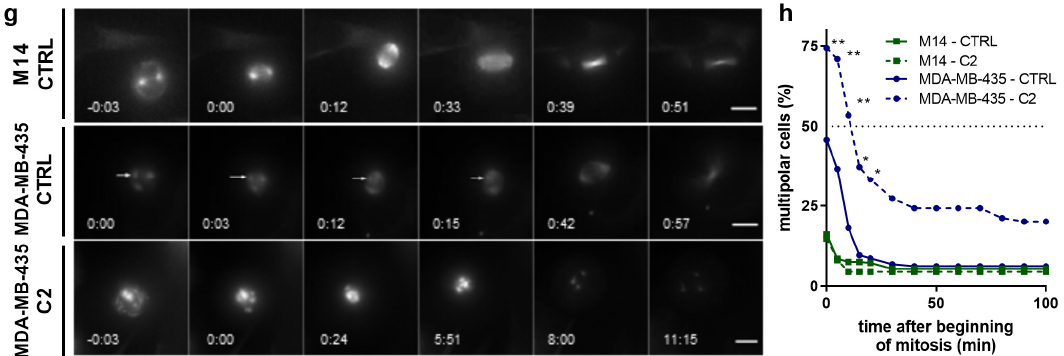
Figure 5. Effects of C2 treatment on melanoma cells with normal or elevated number of centrosomes. ( a ) Representative images of M14 and MDA-MB-435 cells stained for centrin (green), γ -tubulin (red), and DAPI (blue). Scale bar = 5 µm. ( b ) Image-based quantification of the number of centrioles per cells. Results from N = 4 experiments with n = 165 cells for M14 and 164 cells for MDA-MB-435 cells. (c) Efficacy of C2 and corresponding single drug treatments in M14 and MDA-MB-435 cells, ** p < 0.01 versus all corresponding single drug treatments in a one-way ANOVA with posthoc Tukey’s multiple comparison test. ( d ) Outcomes of M14 and MDA-MB-435 cells treated with CTRL (0.1% DMSO) or C2 during 24h movies. ** p < 0.0001 vs. CTRL in a Fisher’s exact test, N = 3 experiments, n = 610–515 cells for M14, and n=355-297 cells for MDA-MB-435 cells. ( e ) Mitotic timing from NEBD until formation of a cleavage furrow in min. ** p < 0.0001 for M14 cells and * p = 0.0002 for MDA-MB-435 cells, (CTRL vs. C2 ) in a Mann–Whitney Test from N = 3 experiments with n = 227–122 cells for M14 and n = 140–60 cells for MDA-MB-435. ( f ) Mitotic outcome of M14 and MDA-MB-435 cells. ** p < 0.0001 and * p < 0.001 vs. CTRL in a Fisher’s exact test, N = 3 experiments with n = 227–122 cells for M14 and n = 140–60 cells for MDA-MB-435. ( g ) Time-lapse images of M14 and MDA-MB-435 cells undergoing mitosis, stained with SiR-Tubulin. Mitotic timing in h:mins using nuclear envelope breakdown (NEBD) as T = 0. Arrows indicate spindle poles in the C2 -treated multipolar MDA-MB-435 cells. Scale bar = 10 µm. ( h ) Percentage of multipolar cells over time. * p < 0.05 and ** p < 0.01 vs. CTRL in a two-way ANOVA with Sidak’s multiple comparisons test from N = 3 experiments with n = 227–122 (CTRL) and n = 140–60 cells ( C2 ) M14 and MDA-MB-435 cells. Error bars represent SEM in all graphs.